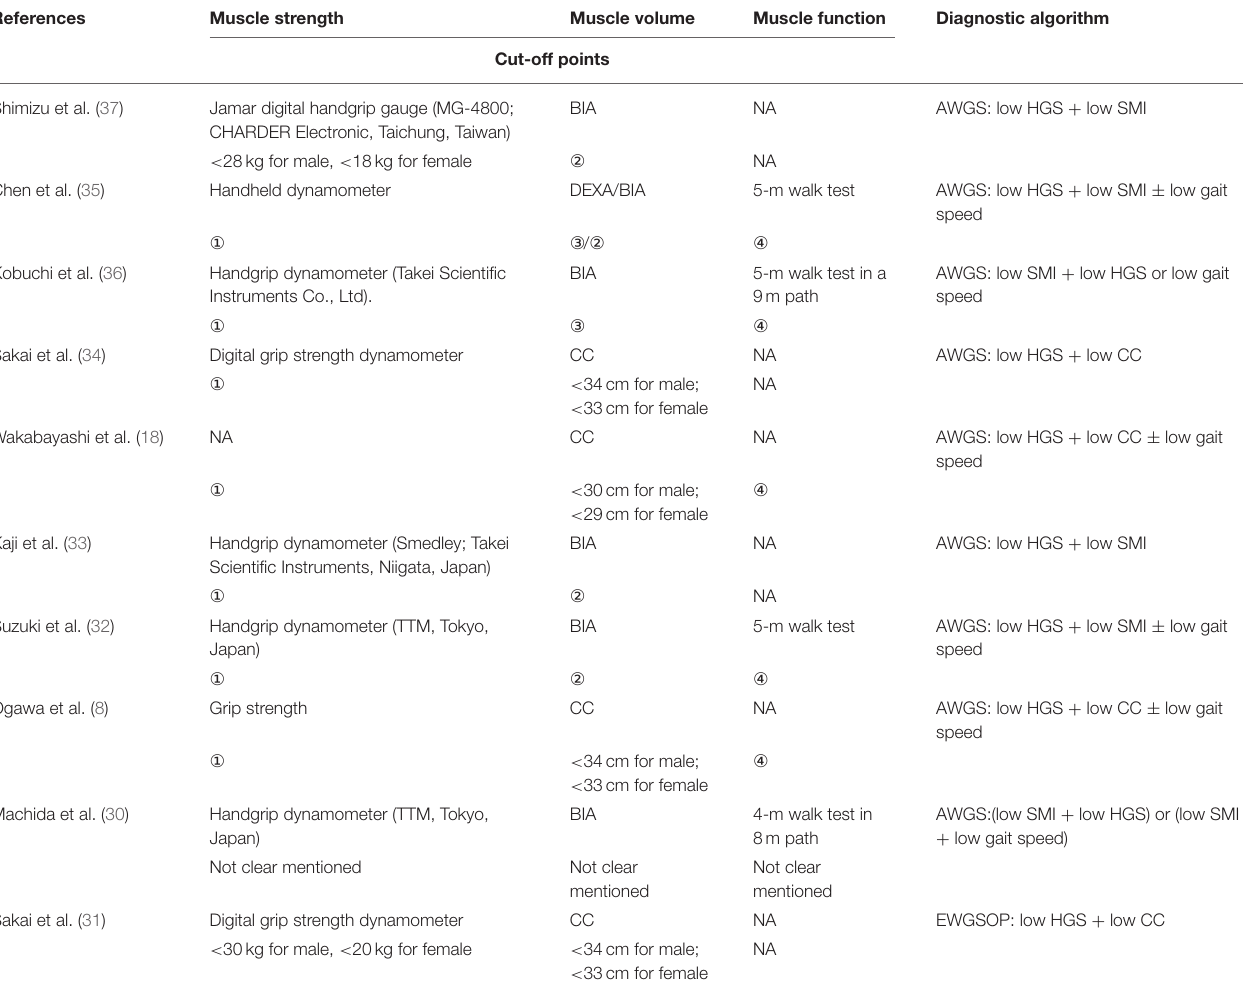
TABLE 2 | Diagnostic tools and criteria of sarcopenia in the included